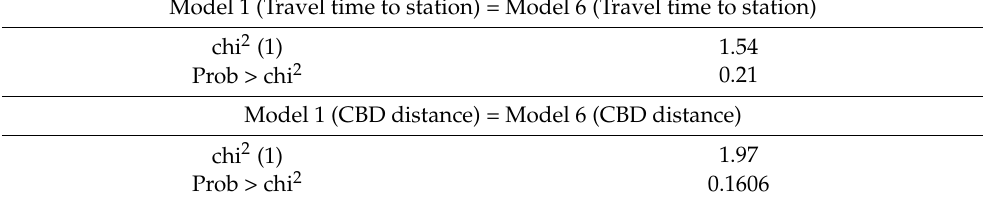
Table 3. Wald test